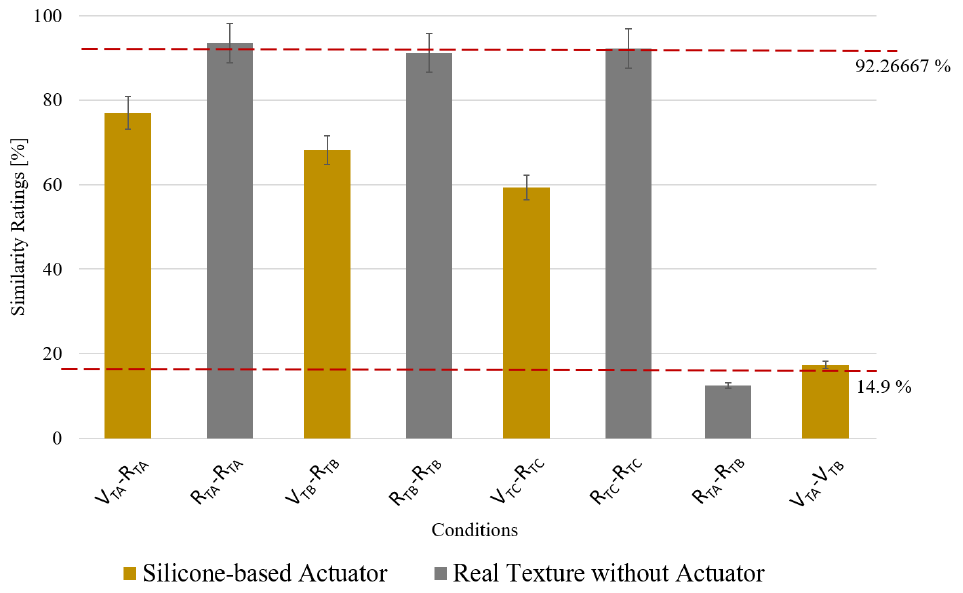
Figure 11. Average similarity scores from the similarity experiment. The error bars show the standard error. Note that V represents virtual, R real, TA Type A, TB Type B, and TC Type